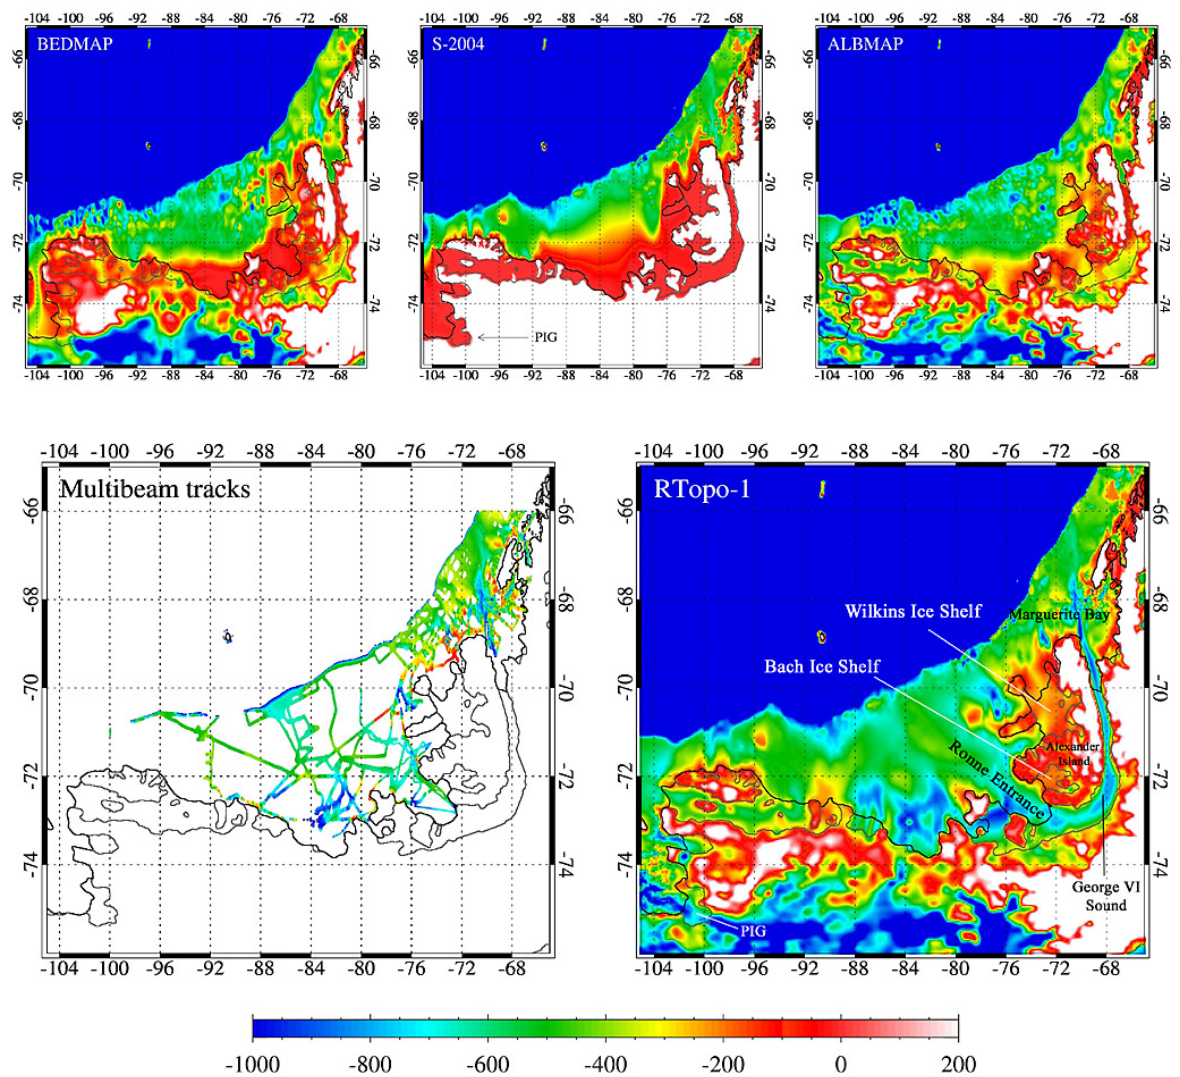
Figure 6. Di ff erent representations of bathymetry (bedrock topography) in the Bellingshausen Sea. Top row: BEDMAP (left), S-2004 (middle), and ALBMAP (right). Bottom row: Multibeam track data (left), and the RTopo-1 product (right). Note the di ff erences for Pine Island Glacier (PIG) and George VI sub-ice bathymetries. Black line represents the coastline or ice shelf front, dark grey line the grounding